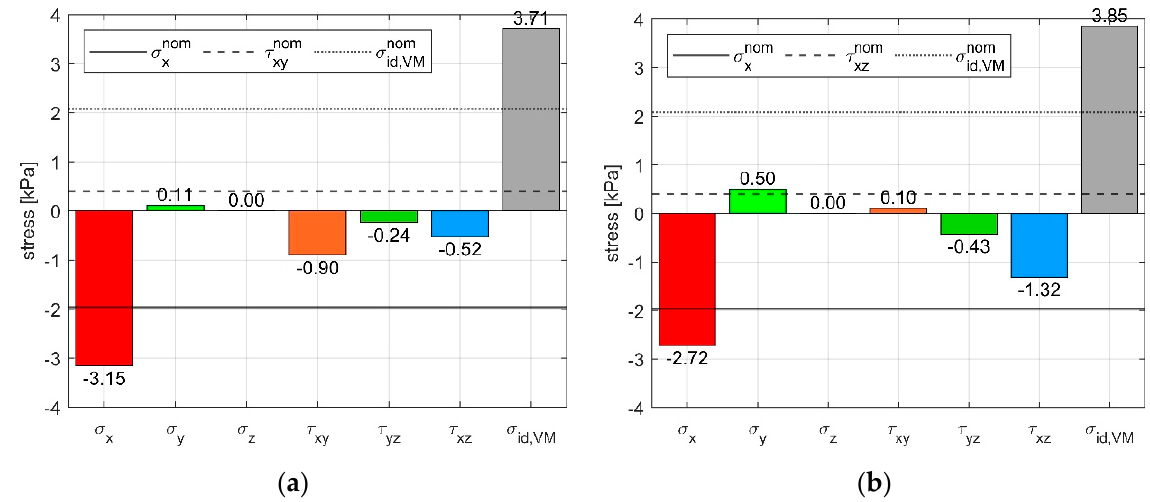
Figure 12. Shear stress computed from the analytical solution during combined loads: ( a ) Compression on X plus shear in XY direction. ( b ) Compression on X plus shear in XZ direction.